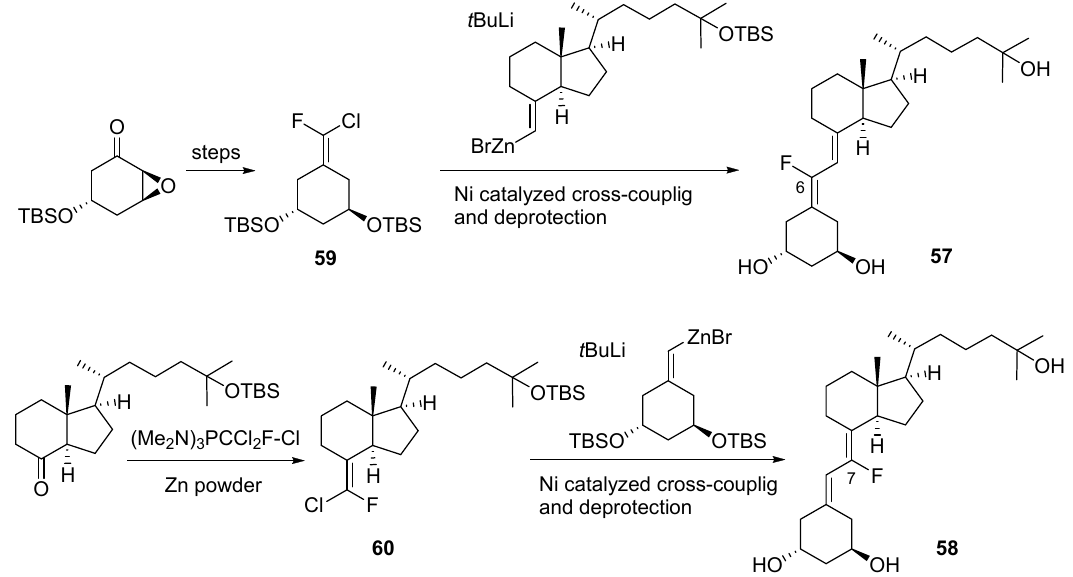
Scheme 20. Efficient introduction of the C6- and C7-fluorovinyl unit to the A-ring or CD-ring followed by construction of the diene structures using a Ni-catalyzed cross-coupling reaction.